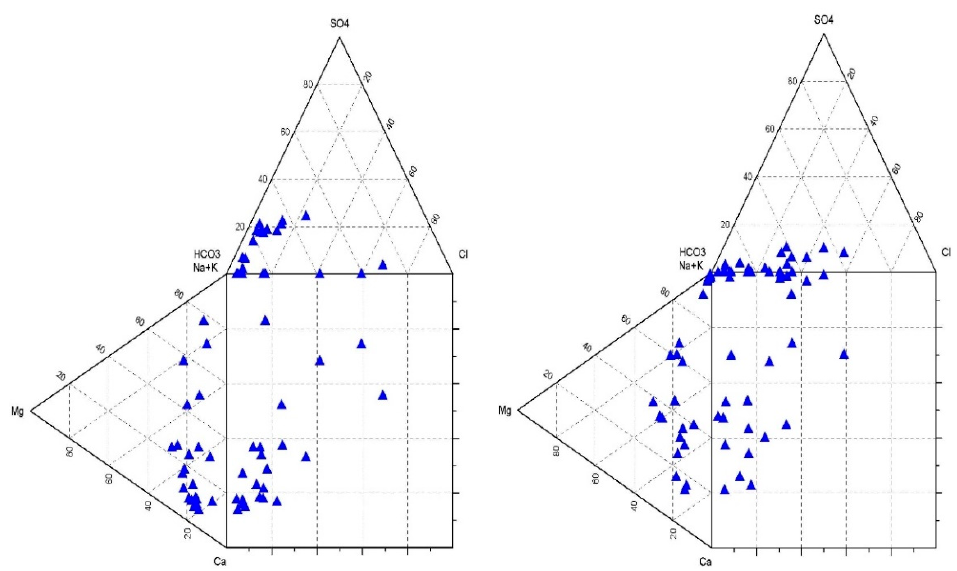
Figure 19. Durov diagrams for the groundwater samples from the unconfined ( left ) and confined ( right ) wells of the study area (May 2019).